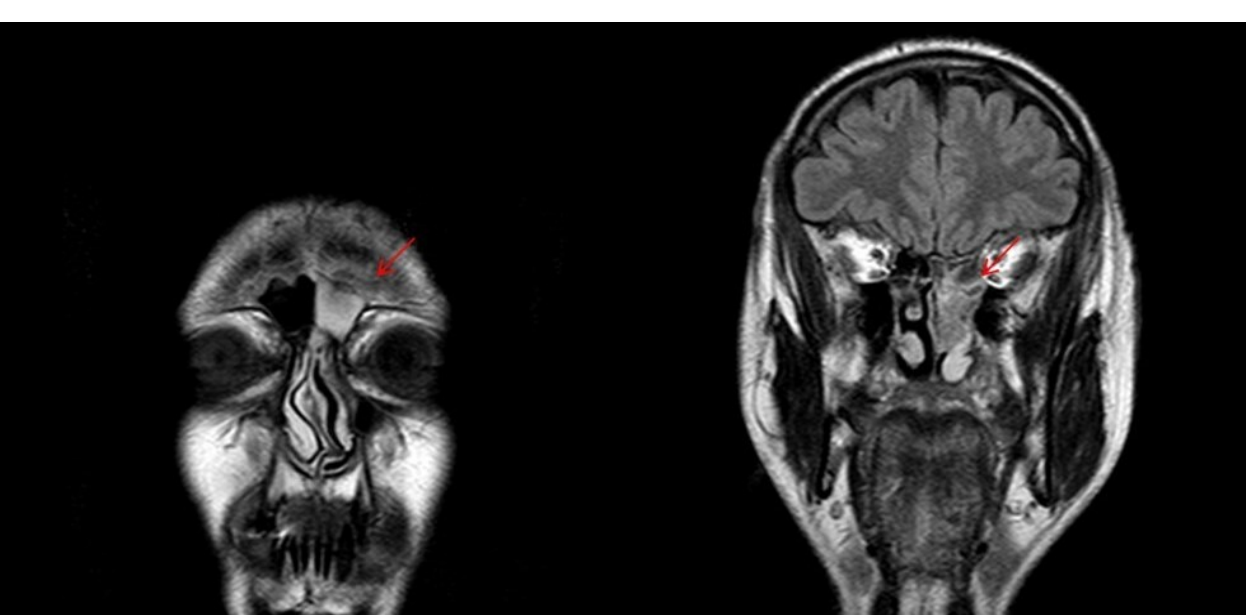
Figure 6. ( A , B , C , D ) Axial and coronal contrast enhanced fat-suppressed T1-weighted image CT scan of head performed after surgery. The arrow indicates persistence of inflammatory tissue.